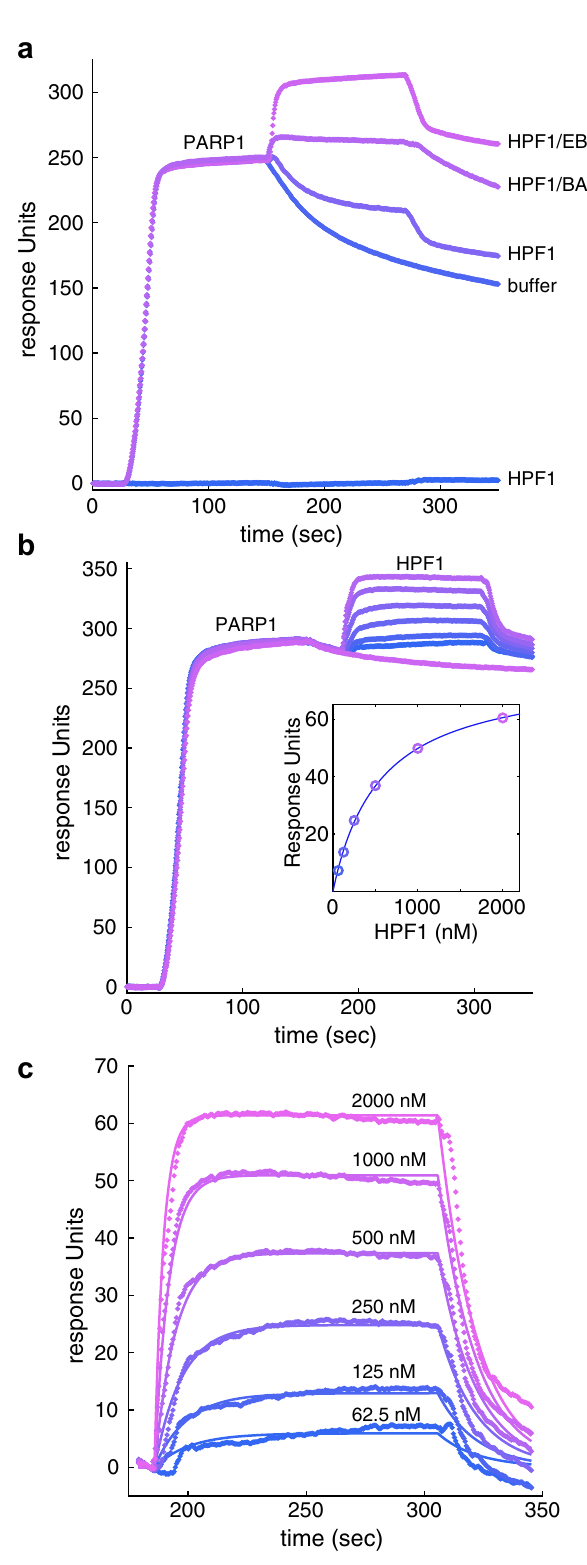
relative to PARP1 alone (Supplementary Fig. 5A, B, C). The initiation rate that we measured in the absence of HPF1 (0.0033 s − 1 ± 0.0015; Supplementary Fig. 5A, C) is comparable to the k cat measured previously (0.0055 s − 1 ) using 3 ’ deoxy-NAD + , which is limited to the initiation reaction since the ADP-ribose cannot be extended 29 . In the presence of HPF1, the initiation rate was increased to 0.12 s − 1 ± 0.02 (Supplementary Fig. 5B, C). As a